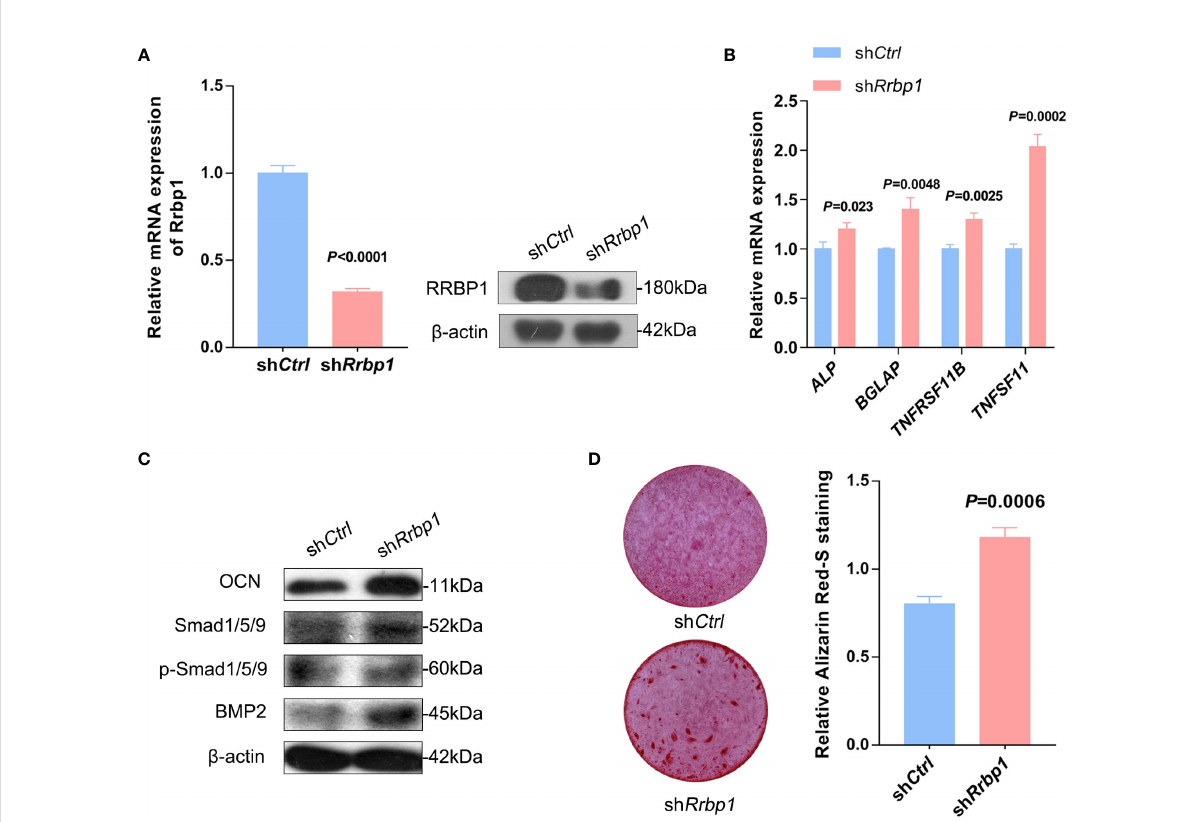
FIGURE 5 The osteoblastic phenotype expression in MC3T3-E1 cells transduced with sh Rrbp1 . (A – C) MC3T3-E1 cells transduced with sh Rrbp1 were cultured with a mineralized medium for 7 d. The relative mRNA level of Rrbp1 was measured via qPCR assay and the protein levels of RRBP1 and b -actin were measured via western blotting analysis (A) . Relative mRNA levels of ALP, BGLAP, TNFRSF11B , and TNFSF11 were measured via qPCR assay (B) . The protein levels of OCN, BMP2, Smad1/5/9, p-Smad1/5/9, and b -actin were measured via western blotting analysis (C) . (D) MC3T3- E1 cells transduced with sh Rrbp1 were cultured with a mineralized medium for 28 d, followed by ARS staining. Left panel: representative images; right panel: absorbance values at 575 nm of different groups. The data are representative of three independent